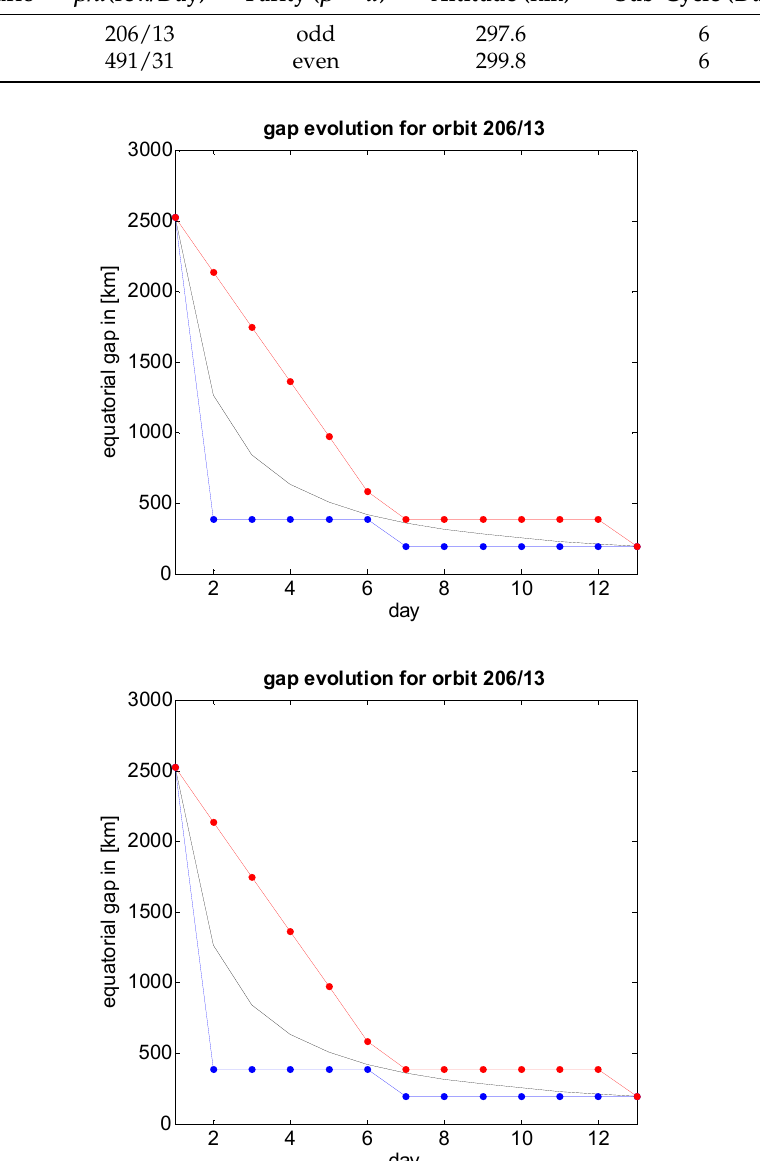
Figure 7. Gap evolution graphs for the repeat orbits of the Table 2 mission scenarios. The blue, red and black curves show the minimum, maximum and average unobserved gaps for each day, respectively.